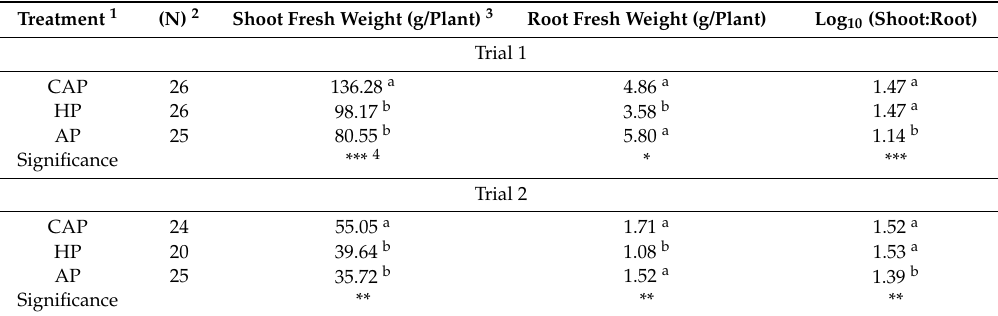
Table 2. LS means of shoot and root fresh weight and shoot:root ratio of harvested